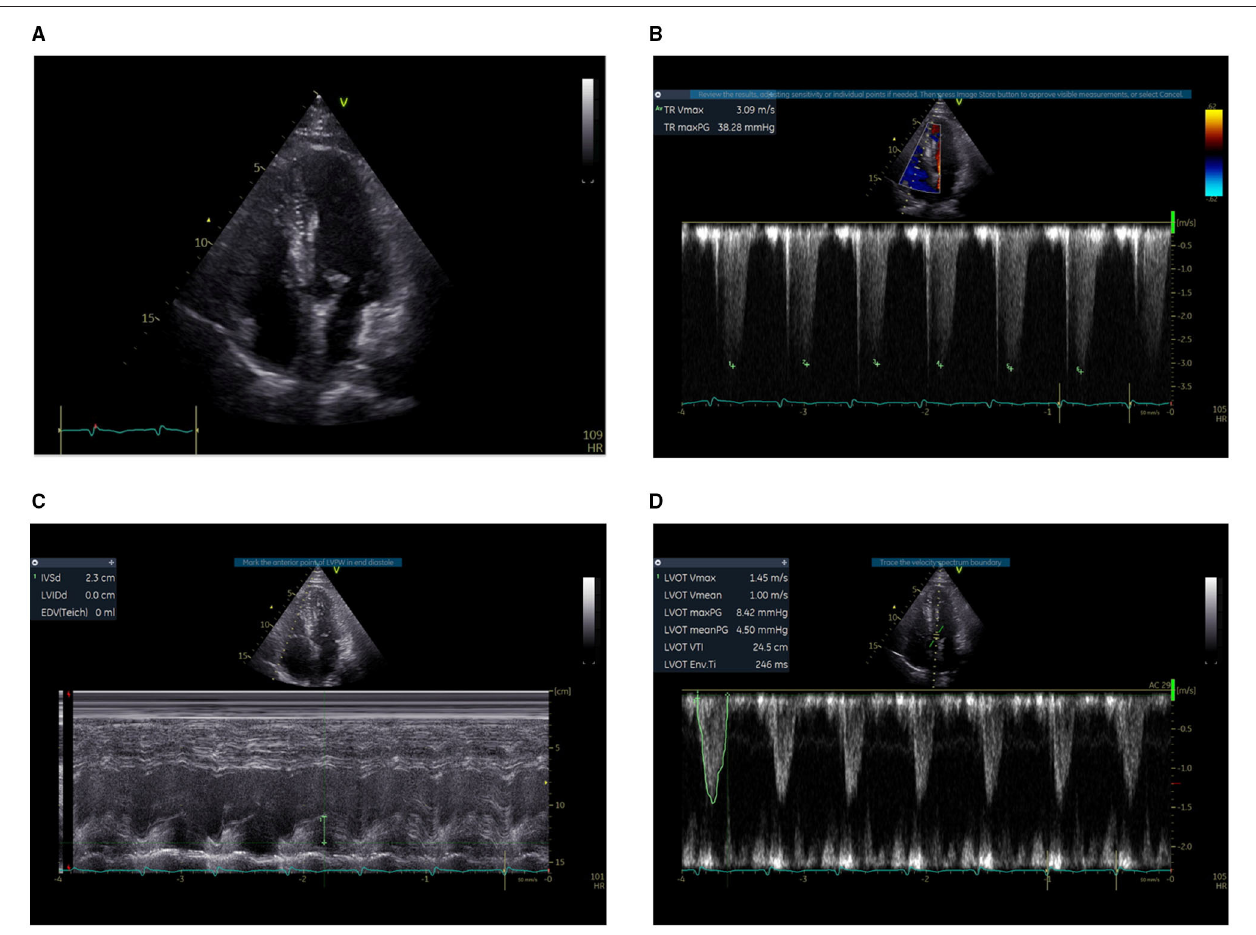
FIGURE 3 | Bedside TTE before thrombolysis. (A) The right ventricle was not clearly displayed, with an estimated ratio of less than 1:1 between the RV and the LV. (B) The TVR was 3.09 m/s. (C) The systolic function of the RV measured by TAPSE was 2.3cm. (D) The LVOT VTI was 24.5 at an HR of 105 b.p.m. and the estimated CO was 8.07